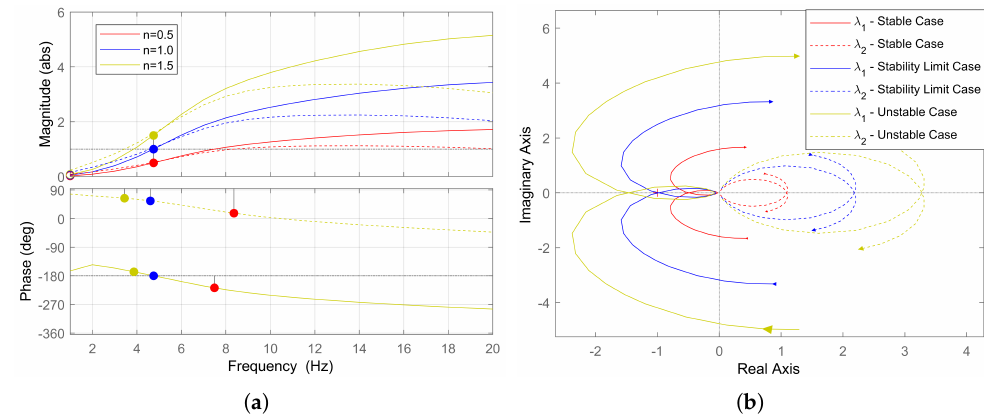
Figure 5. System eigenvalues ( λ 1 , λ 2 ) of the three study cases. Stable case (red): gain margin = 2 at 4.75 Hz; stability limit case (blue): gain margin = 1 at 4.75 Hz; unstable case (yellow): gain margin = 0.667 at 4.75 Hz. ( a ) Bode Diagram, ( b ) Nyquist